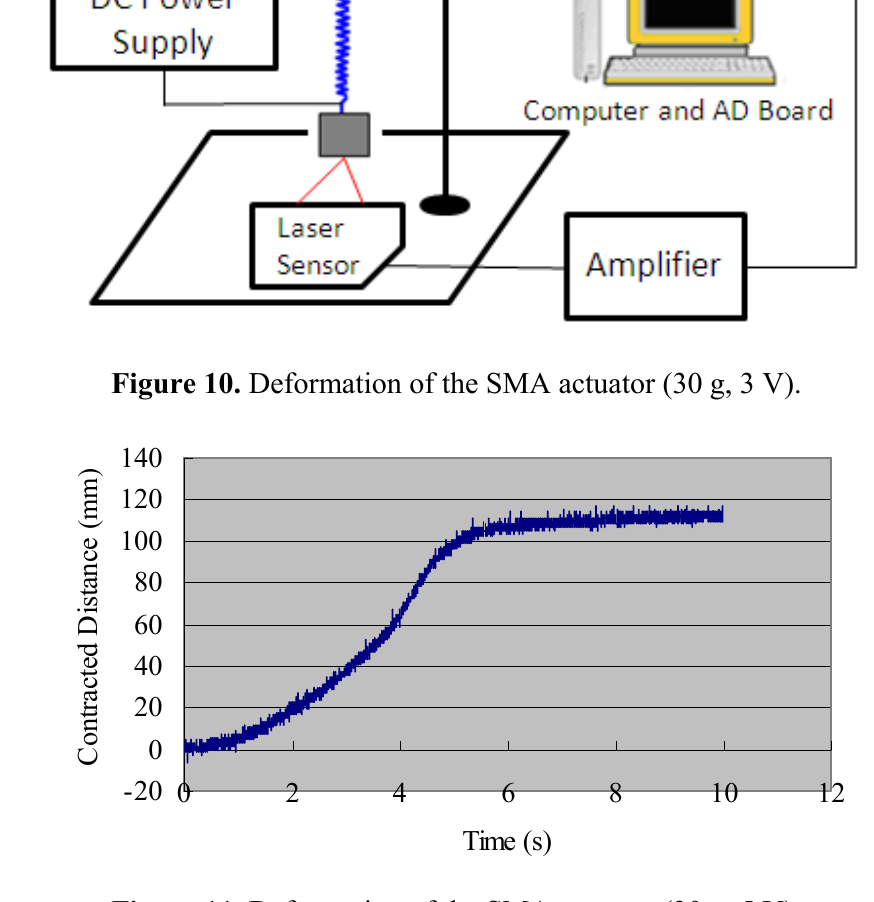
Figure 11. Deformation of the SMA actuator (30 g, 5